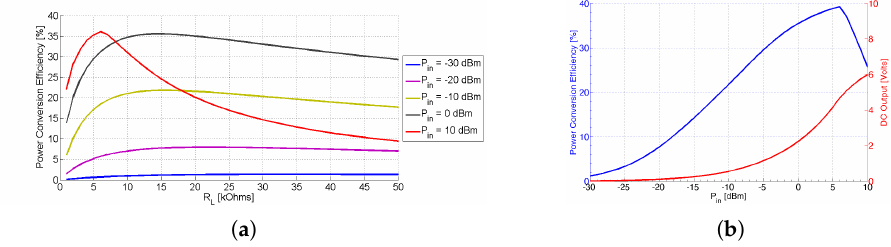
Figure 10. ( a ) Computed RF-to-DC power conversion efficiency versus the output load resistance for various levels of the P in and ( b ) Total computed RF-to-DC power conversion efficiency (triple-tone) and DC output versus P in .